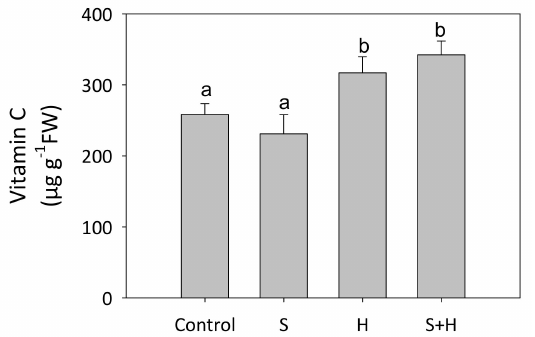
Figure 5. Concentration of vitamin C ( µ g g − 1 fresh weight) in tomato fruits under control (C), saline (S) and heat conditions (H) or the combination of salinity and heat (S + H). Values are means ± SE ( n = 6). Different letters indicate significant differences between means according to Duncan’s test at the 5%